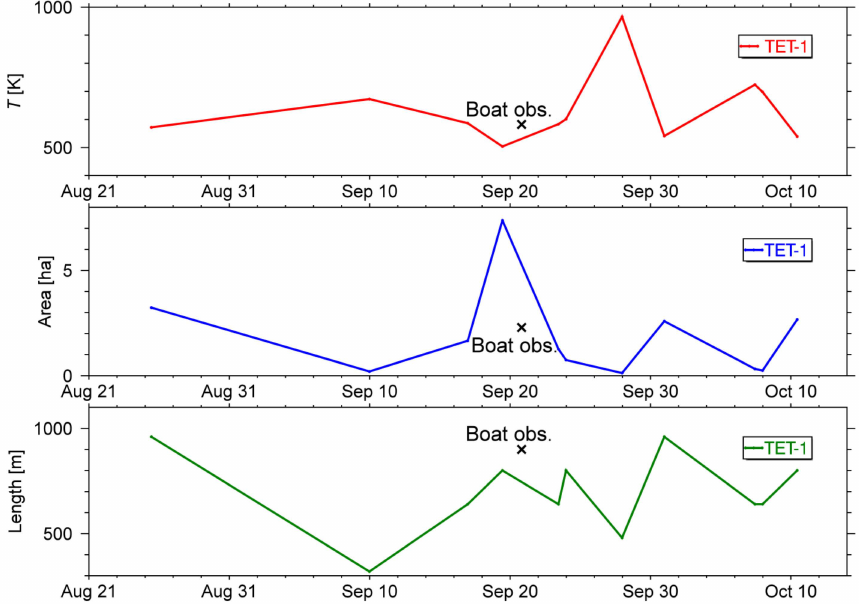
Figure 11. Analysis of the effective temperature, area and length of lava flows from TET-1 data; see Table 7 for exact values.